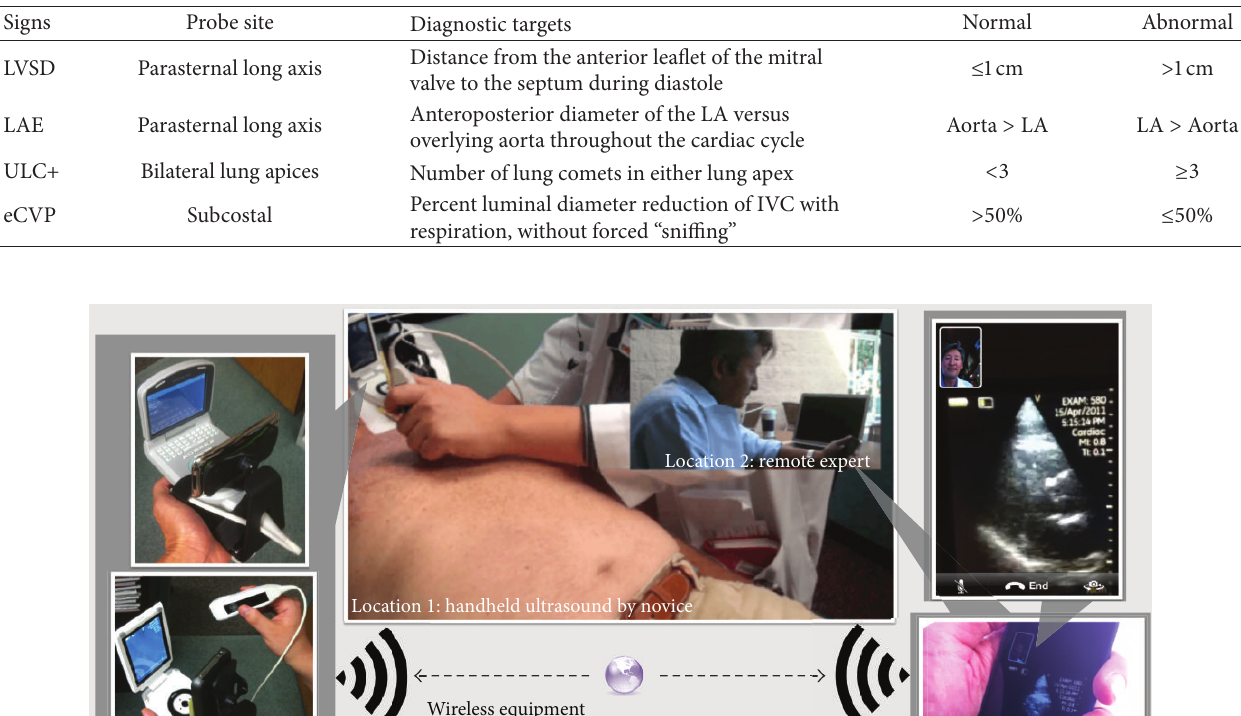
Table 1: Components of the CLUE